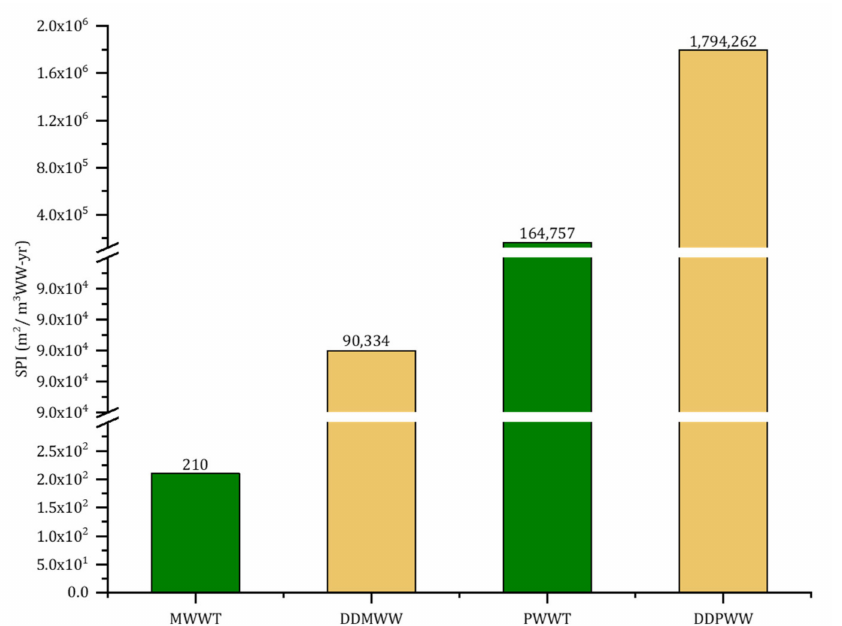
Figure 8. Sustainable process index (SPI) for the various scenarios. (MWWT = municipal wastewater treatment; DDMWW = direct disposal of municipal wastewater; PWWT = pharmaceutical wastewater treatment; DDPWW = direct disposal of pharmaceutical